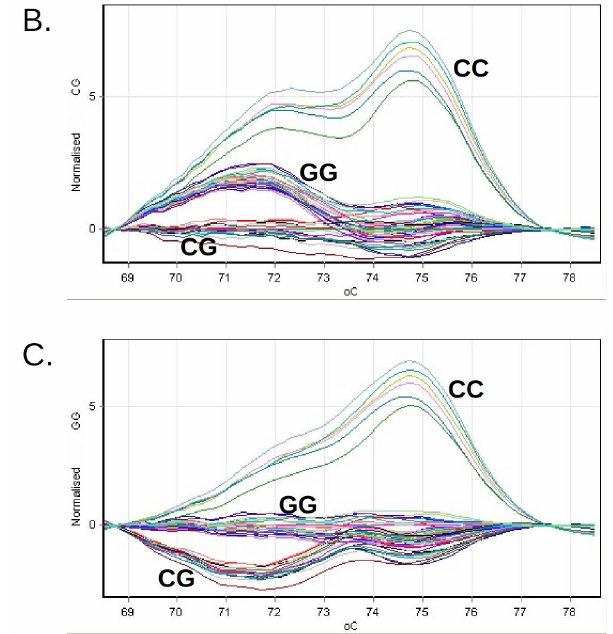
Figure 1. The grouping of the difference curves of the relative fluorescence obtained for the clinical genomic DNA samples during the genotyping by HRM or PNPLA3 on the Rotor-Gene 6000 system. The reference profiles were successively chosen, corresponding to the CC genotype (panel ( A )), CG (panel ( B )) and GG (panel ( C )).